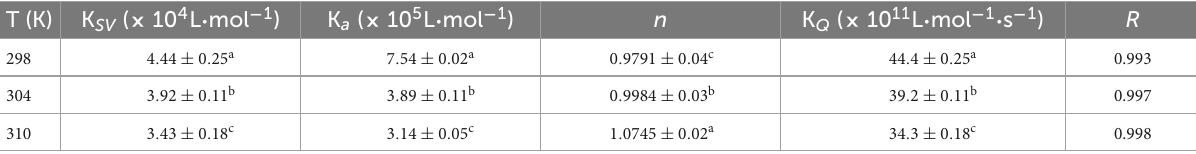
TABLE 1 Quenching constants K SV , binding constants Ka, and the number of binding sites n for the interaction between WP and HES at different temperatures. T